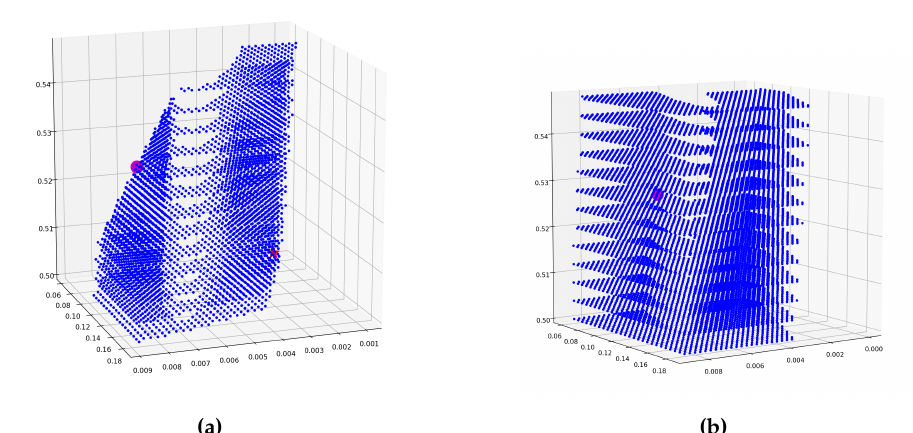
Figure 8. Two examples of (zero-residual) intersection regions I zr ⊂ R 3 with different location of the true solution: inside the region or on its border. For graphical reasons the region has been discretized and the dots are the grid nodes; the bigger ball (thick point) is the true solution. ( a ): The true solution (ball) is on the border of I zr ; ( b ): The true solution (ball) is internal to I zr